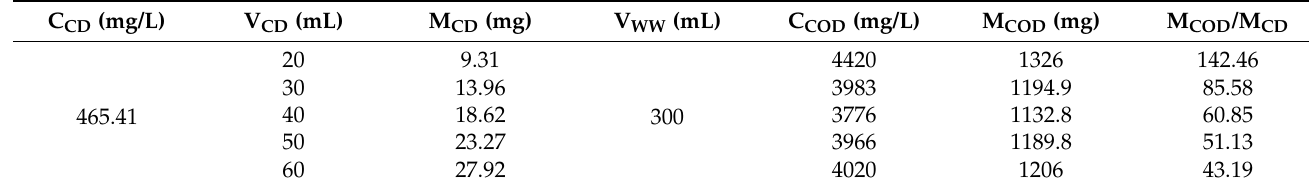
Table 3. The ratio between the COD mass and the mass of the applied chlorine dioxide.